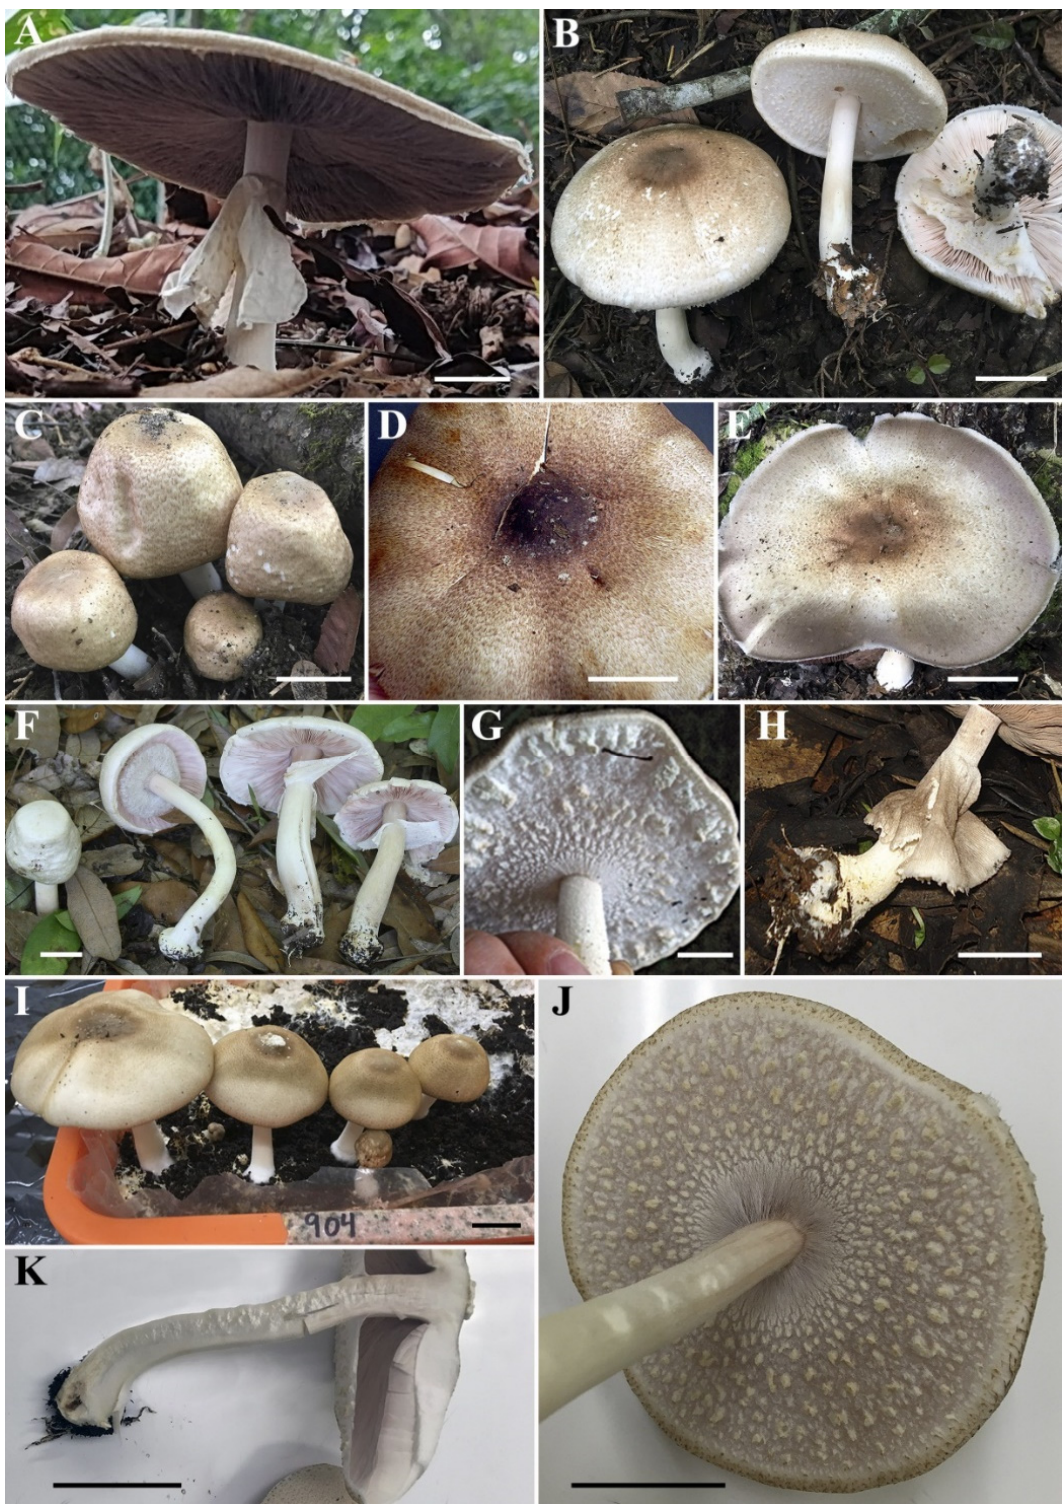
Figure 3. Macroscopic characters of Agaricus macrochlamys from Mexico and USA. ( A – K ) Basidiomata. ( A ) Medel 1961, holotype; ( B ) LD201938; ( C ) LD201927; ( D , G , H ) Medel and Lorea-Hernández 2249; ( E ) LD201934; ( F ) ARB1353; ( I – K ) CUL-IE904. Bar = 2 cm. Photos by Lorea-Hern á ndez ( A , H ); R. Medel ( D , G ); J. Chen ( B , C , E , I – K ); and A.E. Bessette ( F